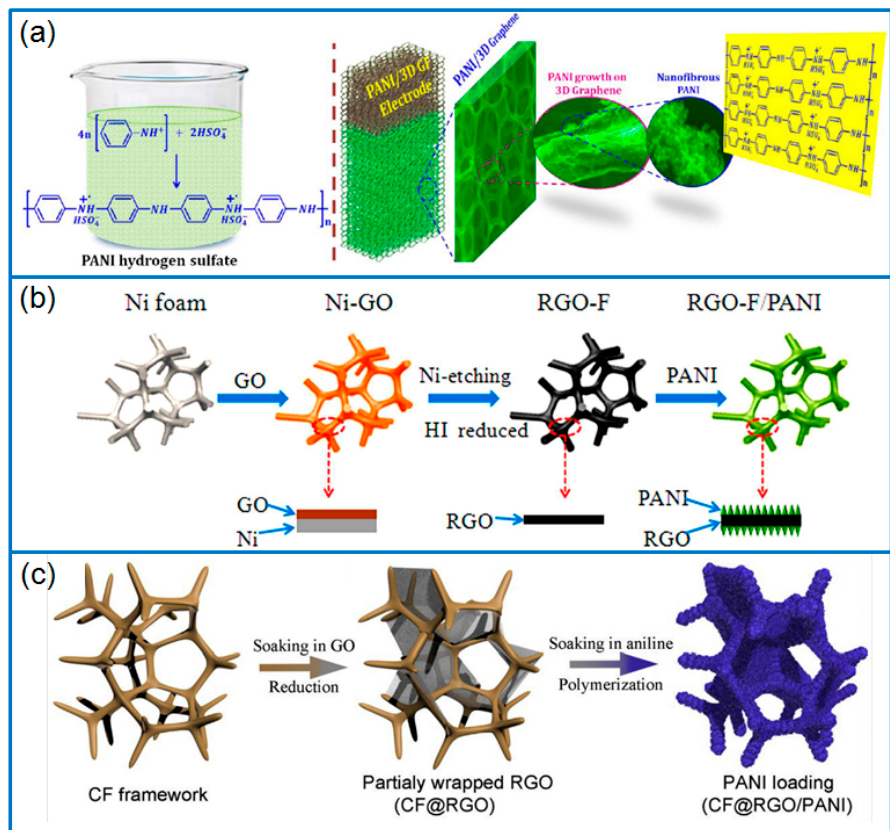
Figure 5. ( a ) Schematic for chemically growing PANI on 3D graphene framework; produced